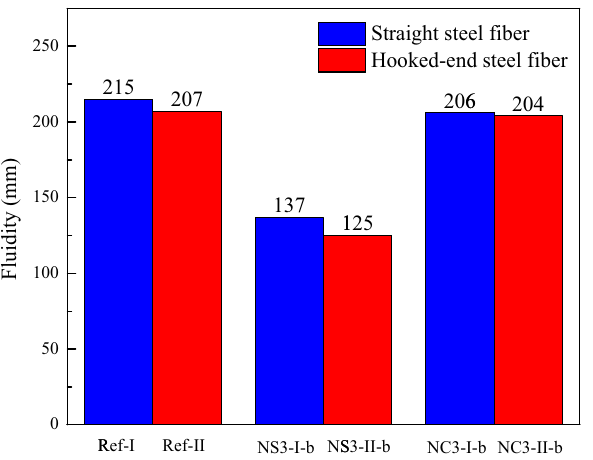
Figure 8: E ff ects of nanomaterials and mixing methods on UHPC paste fl